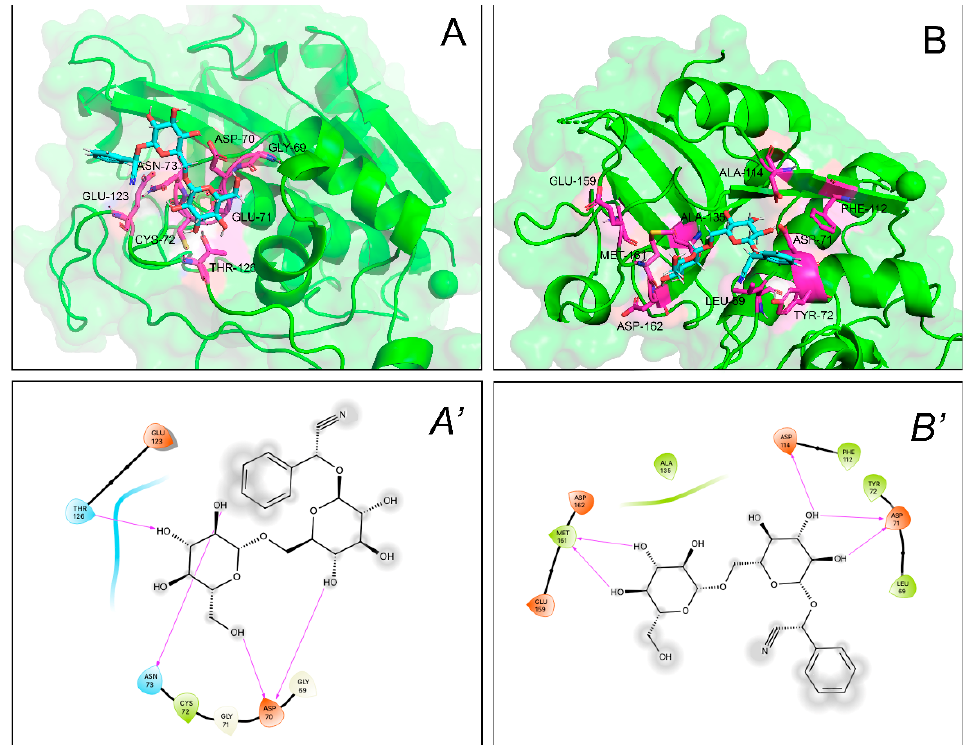
comparative 2D visualization of amygdalin and the residues close to the active site of β 1, β 2, and β 5 subunits, respectively, that are directly involved in the formation of H-bonds (purple arrows), polar (light blue ribbon), and VdW interactions (green ribbon). Atoms/groups exposed to solvent are indicated with grey circles.